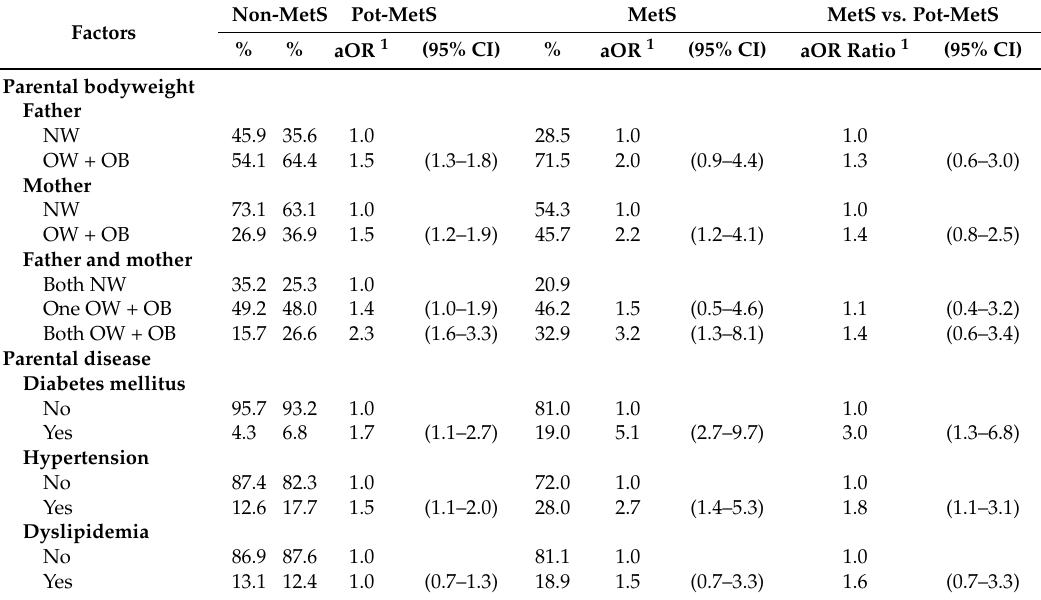
Table 2. Adjusted odds ratios of adolescent potential metabolic syndrome and metabolic syndrome associated with parental risk